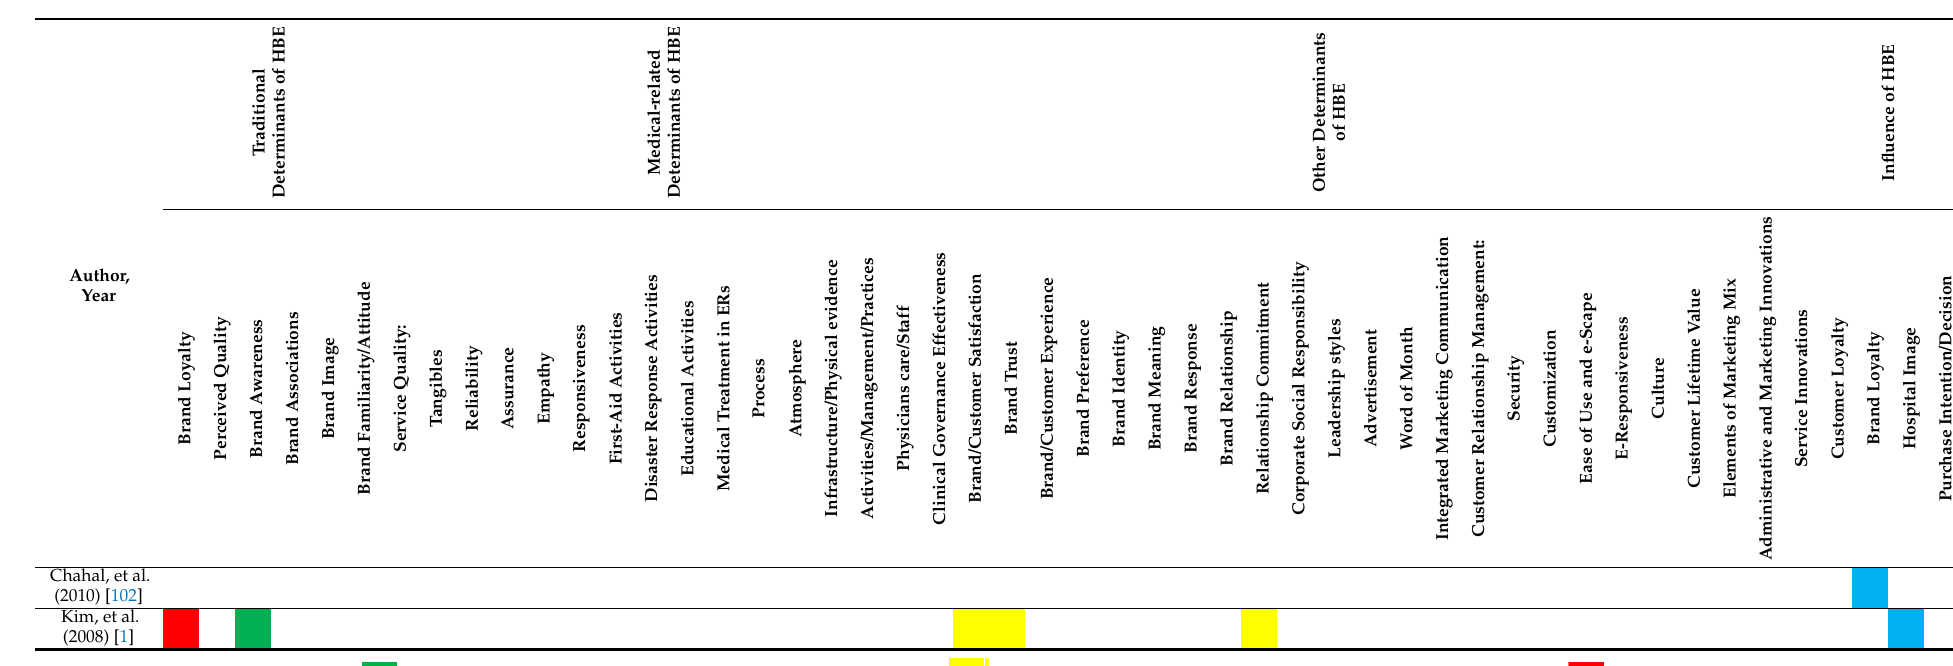
Factor having a direct effect on HBE (statistically significant). Factor having an indirect effect on HBE (statistically significant). Factor studied but not influenced either directly or indirectly by HBE. HBE as a factor affecting other factors.